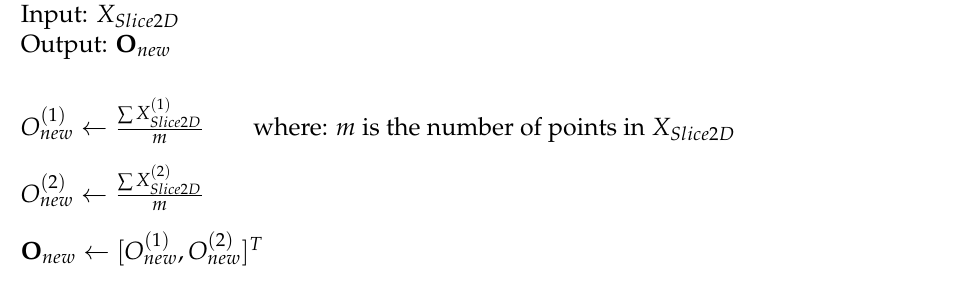
Algorithm A8 Function: Choose a new origin inside the actual slide of Minkowski sum